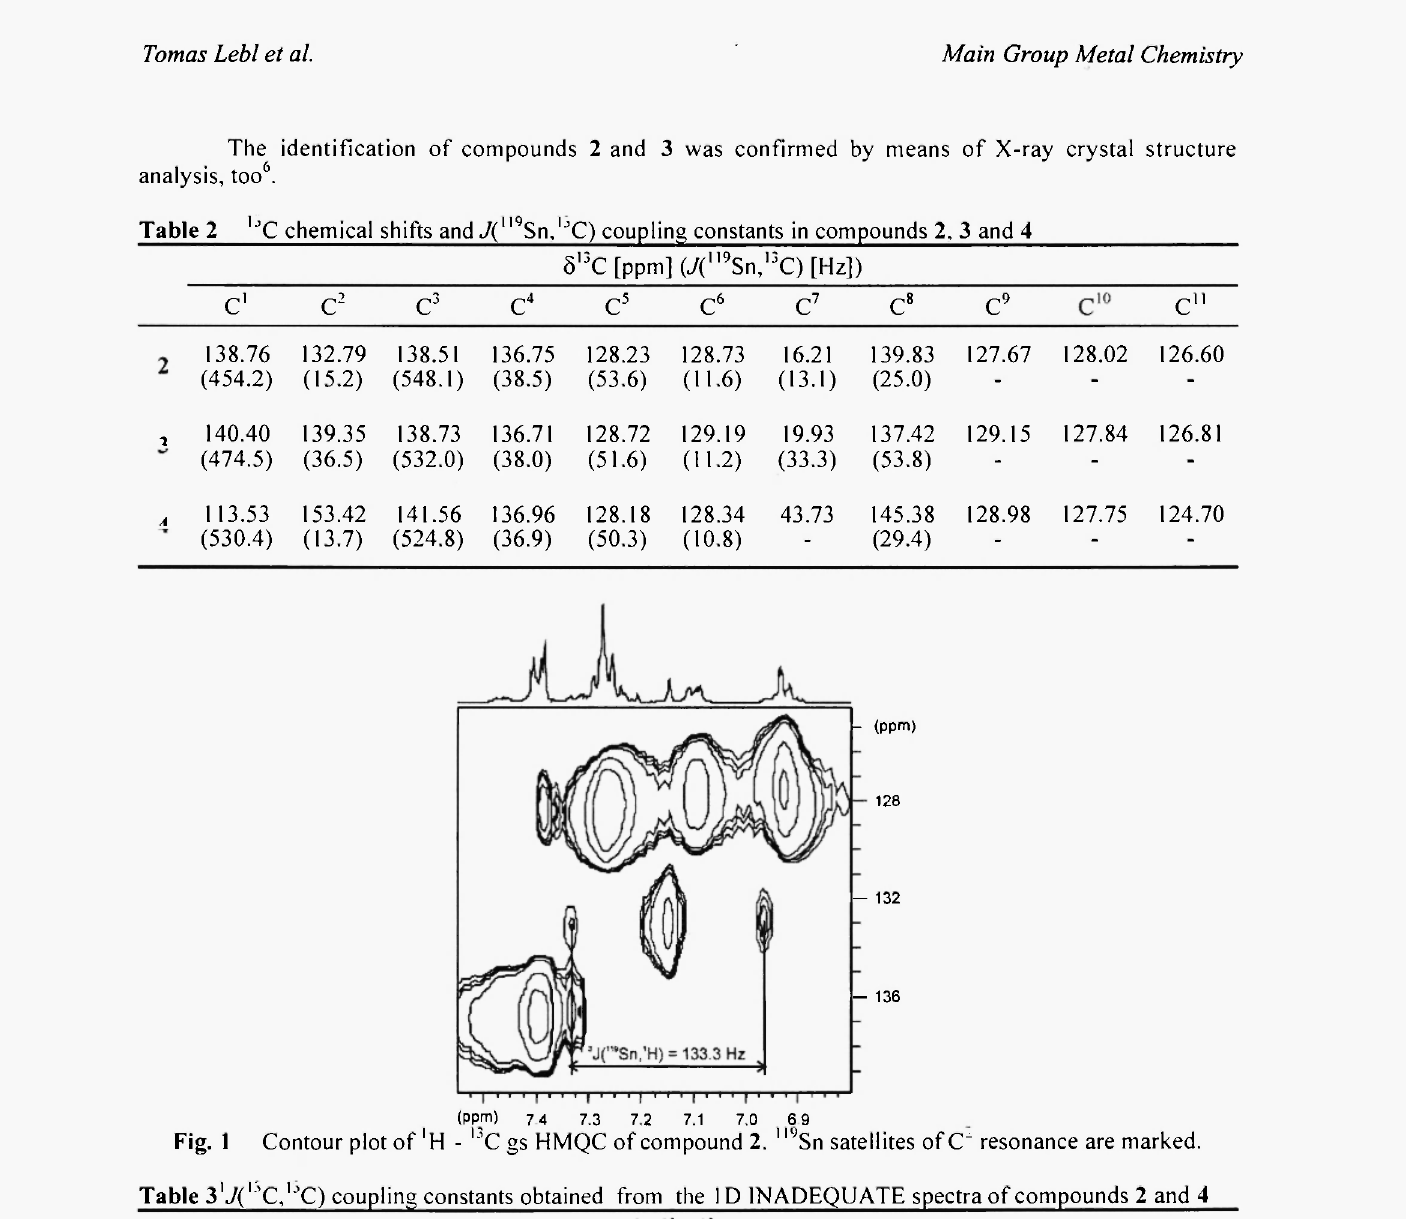
Fig. 1 Contour plot of 'H - l3 C gs HMQC of compound 2. 1 Sn satellites of C resonance are marked. Table 3*J(' 'C, 1 ~'C) coupling constants obtained from the 1 D INADEQUATE spectra of compounds 2 and 4 'J( I3 C, I3 C)